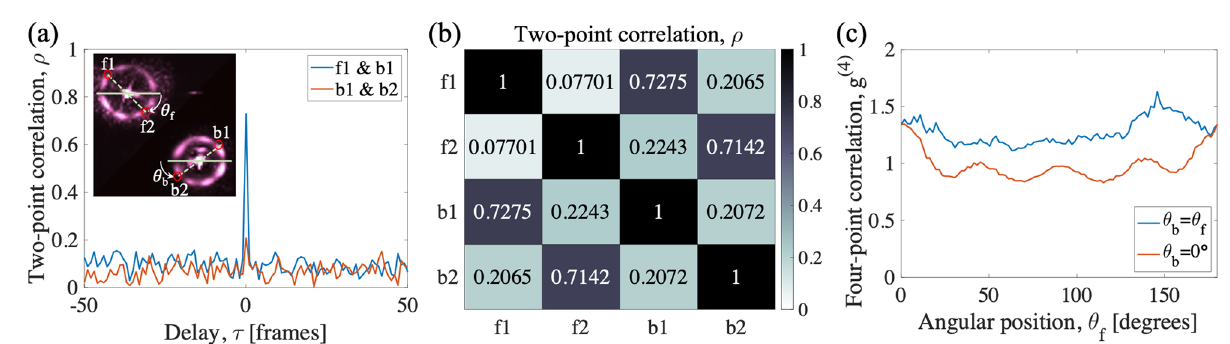
Figure 5. ( a ) Two-point intensity correlation is plotted for two sets of pixels as a function of delay in terms of the camera’s frame number. Inset shows EMCCD camera images for forward and backward AMWM signals. The bright center region is due to the pump leakage. The pixels indicated as f 1, f 2 and b 1, b 2 are two pixels of the forward- and backward-propagating AMWM signals and θ f / b is the angular positions of these pixels from a fixed reference point. ( b ) Two-point correlations for zero time-delay (same frame) are shown for different combinations of four pixels shown in the inset of ( a ). ( c ) Four-point intensity correlation function at zero time delay, g ( 4 ) ( 0 ) , is plotted as a function of angle θ f as shown in the inset of ( a ). Consistent g ( 4 ) ( 0 ) > 1 is seen for many sets of four-pixel sets around the